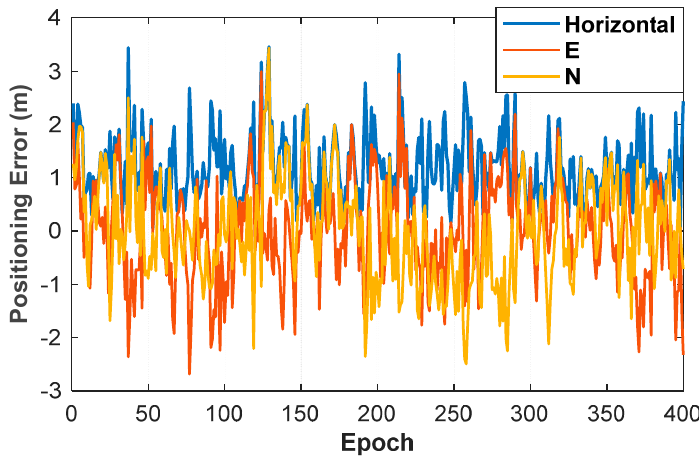
Figure 12. Positioning error of pseudorange measurement.